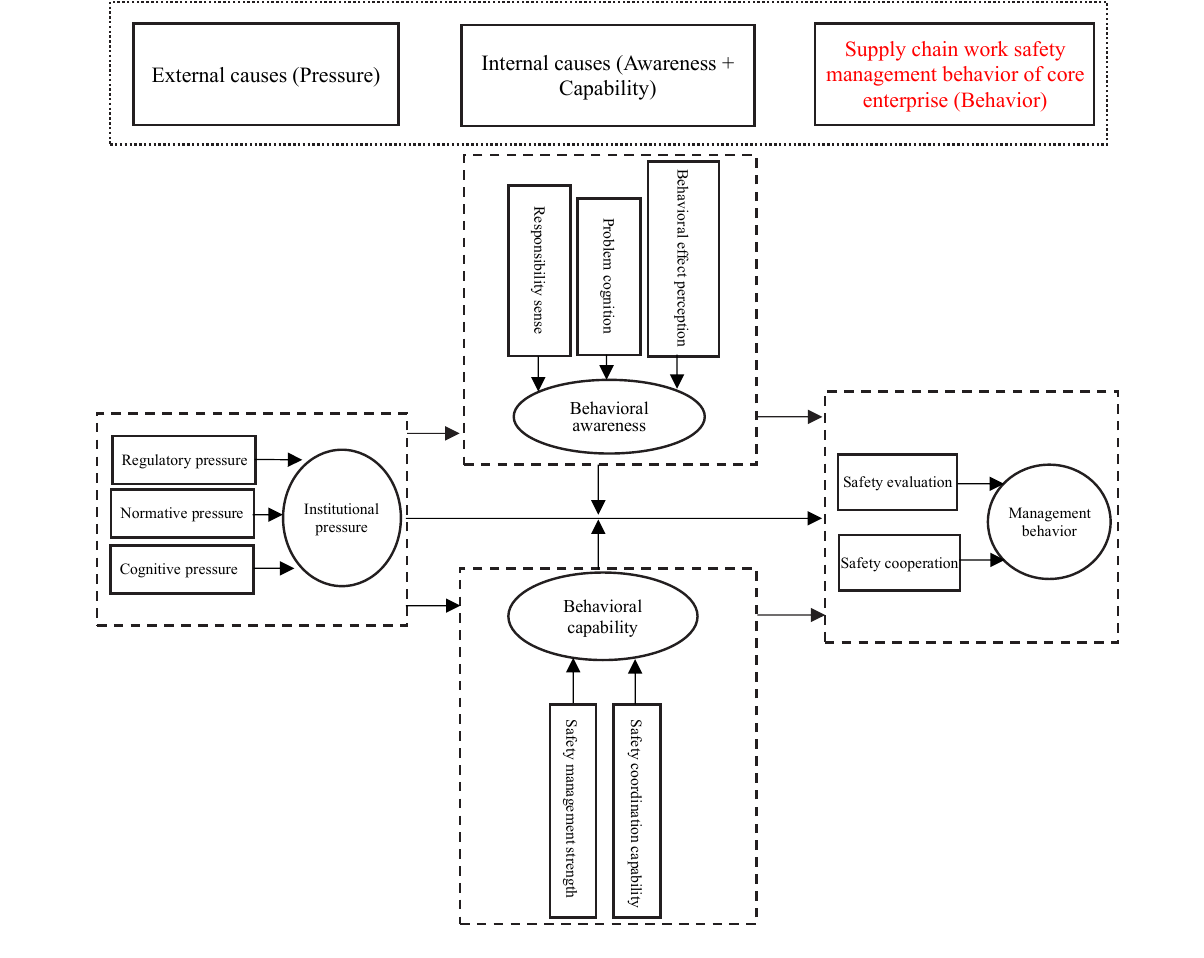
FIGURE 2 | Driving mechanism